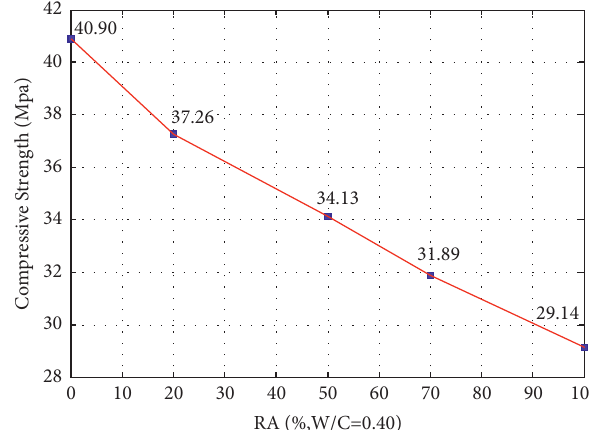
Figure 6: Porosity-RA relationship.